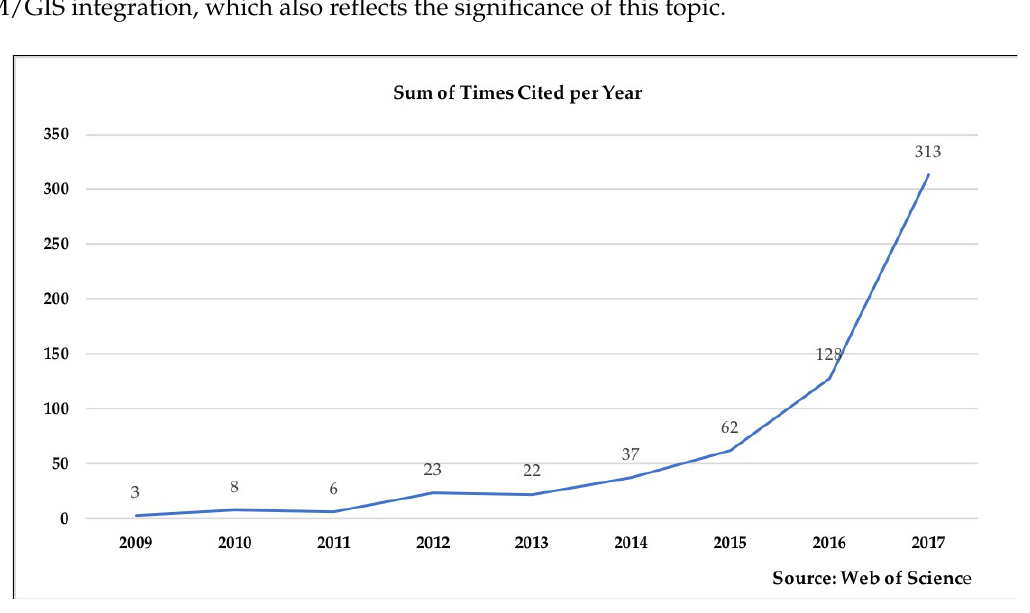
Figure 1. Sum of times cited per year from 2009 to 2017 regrading BIM/GIS